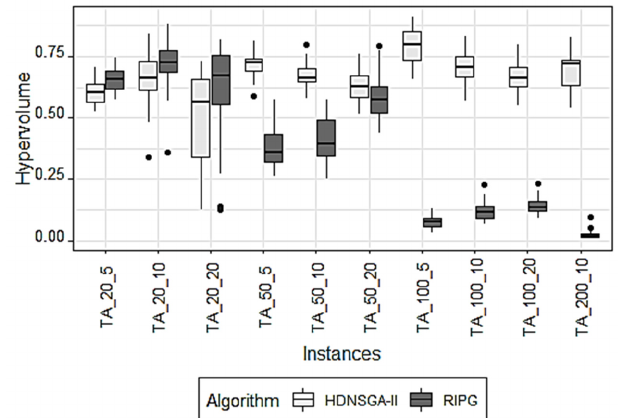
Figure 2. Comparison of the hypervolume evolution with HDNSGA-II and RIPG in each type of instance. The unary multiplicative epsilon indicator behaves in a similar way to hypervolume, as shown in Figure 3. In this case, the lower the value, the better the algorithm.